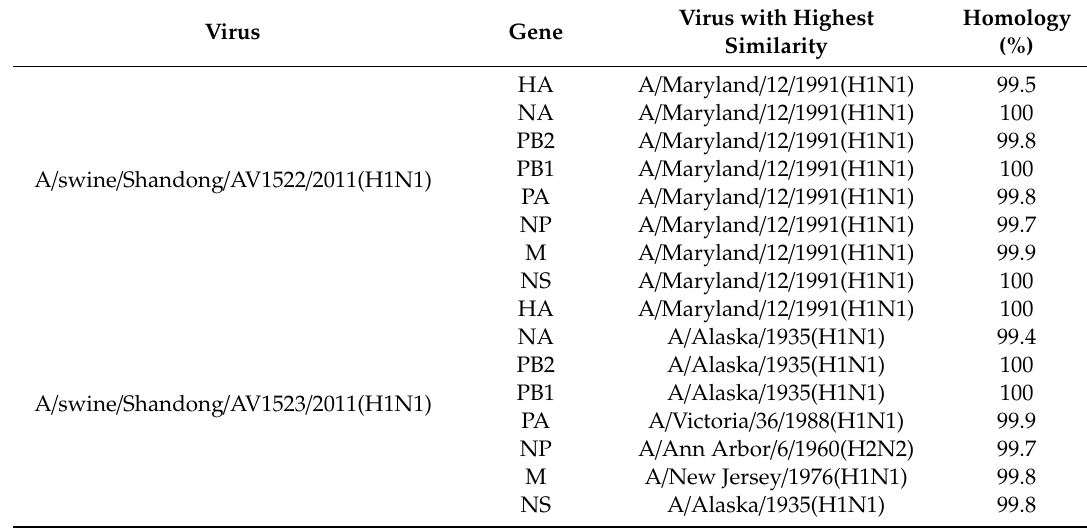
Table 1. The influenza viruses in GenBank with highest nucleotide homology with AV1522 and AV1523 viruses when analyzing each gene fragment. Virus with Virus Gene